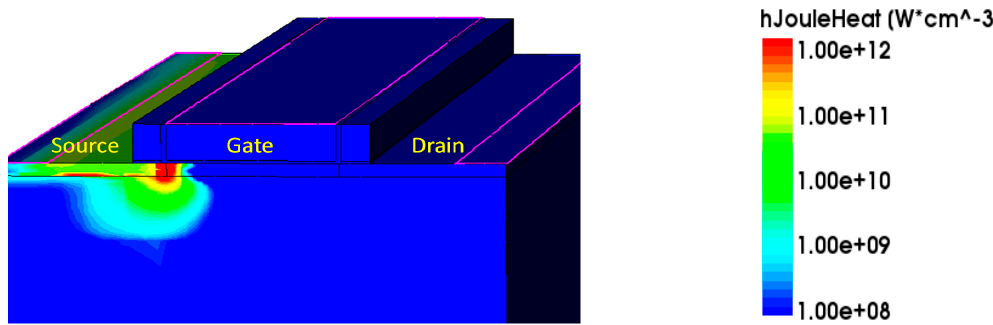
Figure 8. Contour plot of hole Joule heat simulated at 90 ns under a TLP current density of 1 mA/ μ m.